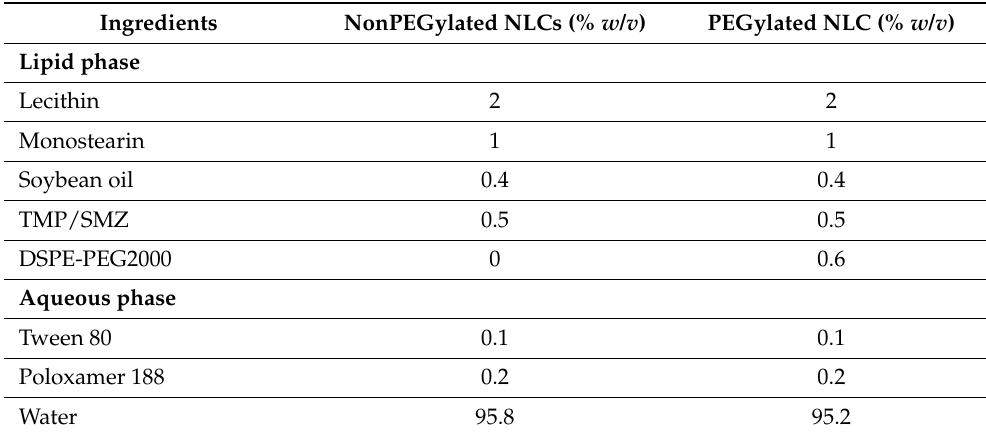
Table 1. Components of the lipid and aqueous phases used for the preparation of nanostructured lipid carriers (NLCs) and polyethylene glycol (PEG)ylated